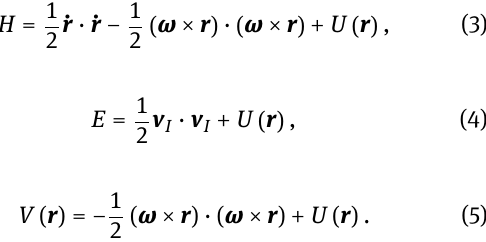
Figure 2. Zero-velocity surfaces with different Jacobi integral values (km 2 ·s −2 ), figure bar represents the location value of the point on